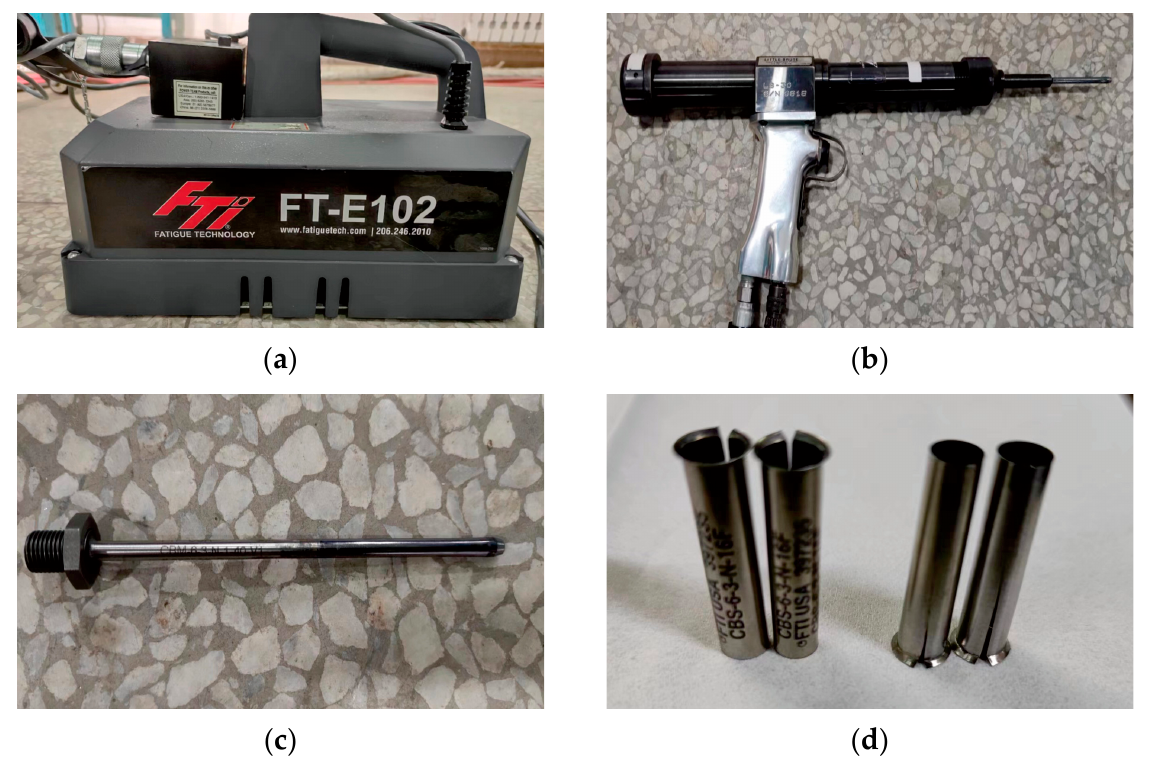
Figure 9. SSCE equipment: ( a ) oil pump; ( b ) pulls gun; ( c ) mandrel; ( d ) split sleeve.